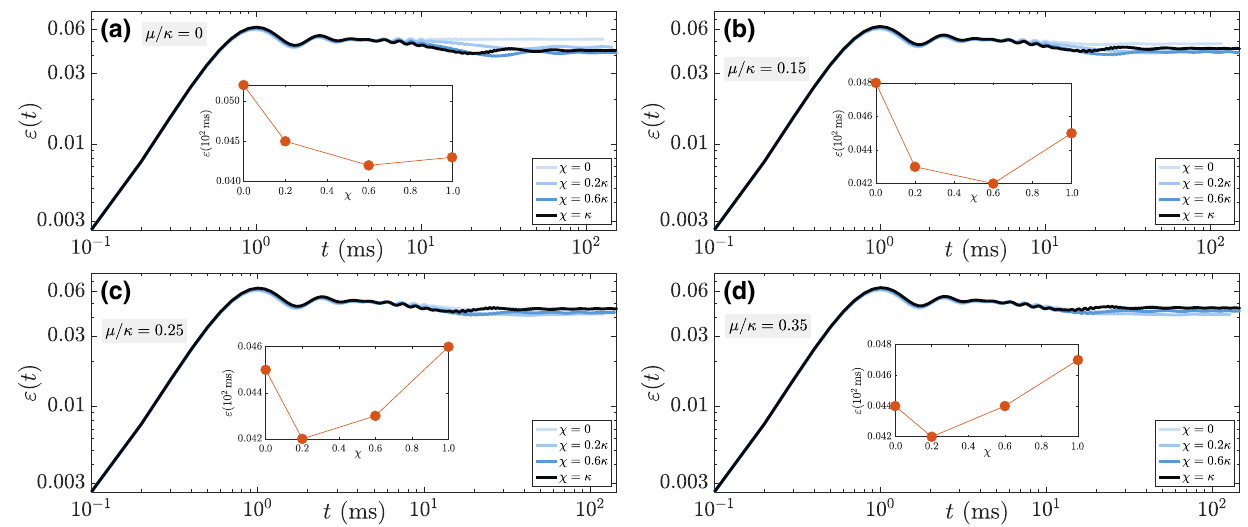
FIG. 8. Same as Fig. 5 but for the gauge violation (14). In the effective implementation using a single bosonic species, gauge invariance is enforced through energy penalties, leading to small violations of the exact gauge symmetry generated by the operators defined in Eq. (4). Nevertheless, the gauge violations remain small and controlled throughout the entire considered evolution times, leading to a renormalized gauge theory with the same U ( 1 ) gauge symmetry as the ideal model (3) [37]. The insets show the value of the violation on a linear scale at t = 100 ms as a function of the considered values of χ . The exact form of the energy penalty and how it arises in our mapping is discussed in Sec. III, and it is closely related to the recently introduced concept of Stark gauge protection